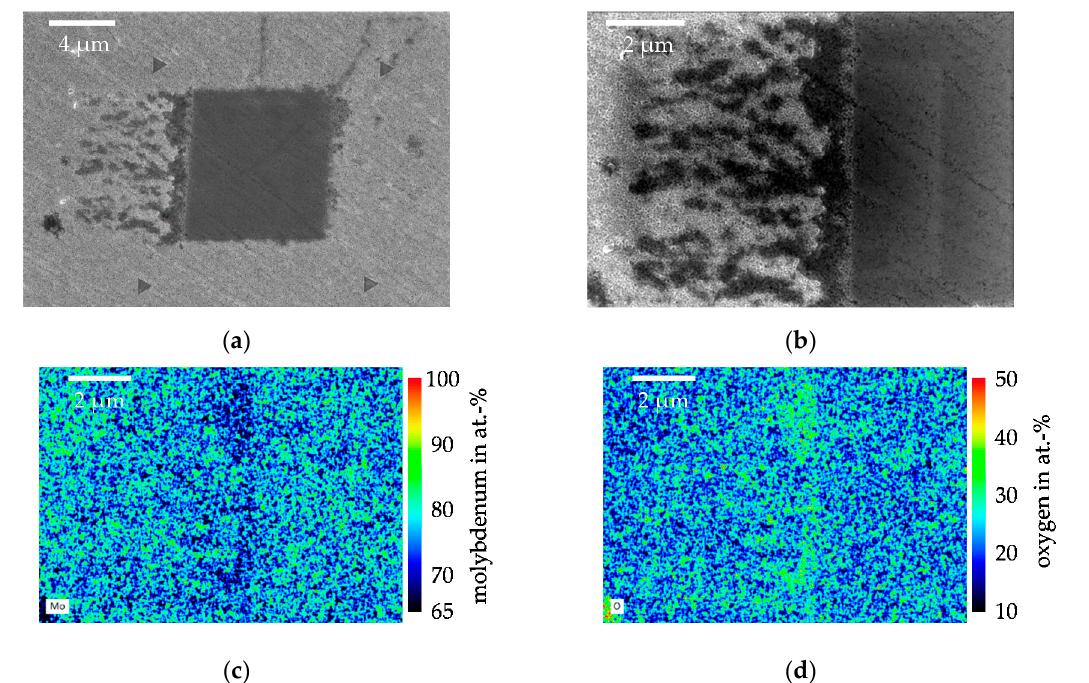
Figure 16. SEM examination of the wear field. ( a ) Secondary electron (SE) image of a wear field with 200 μ N/35 P on Mo; ( b ) Enlarged SE image of the left region of the wear field of ( a ) over which the element mapping was performed; ( c ) Result of the mapping from ( b ) for Mo; ( d ) Result of the mapping from ( b ) for oxygen.